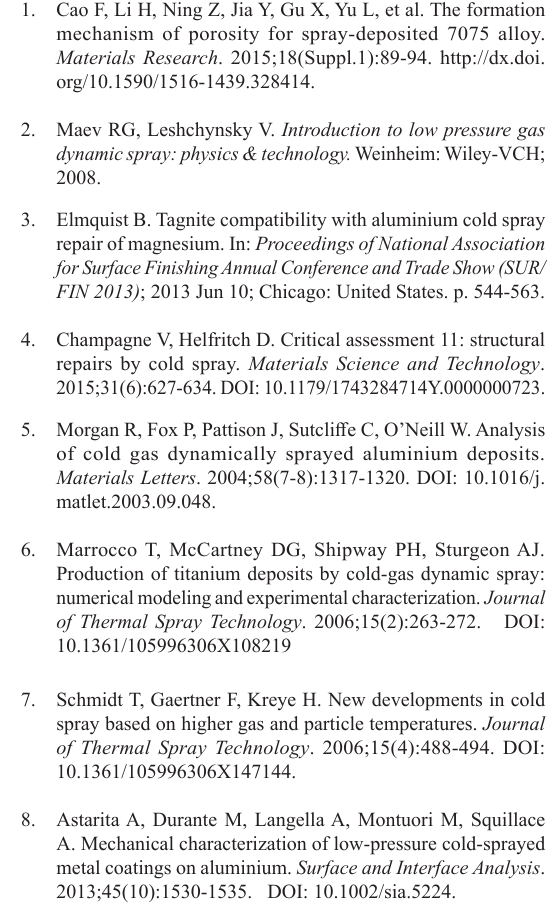
Figure 12: Vickers indentation on the cold sprayed repair.